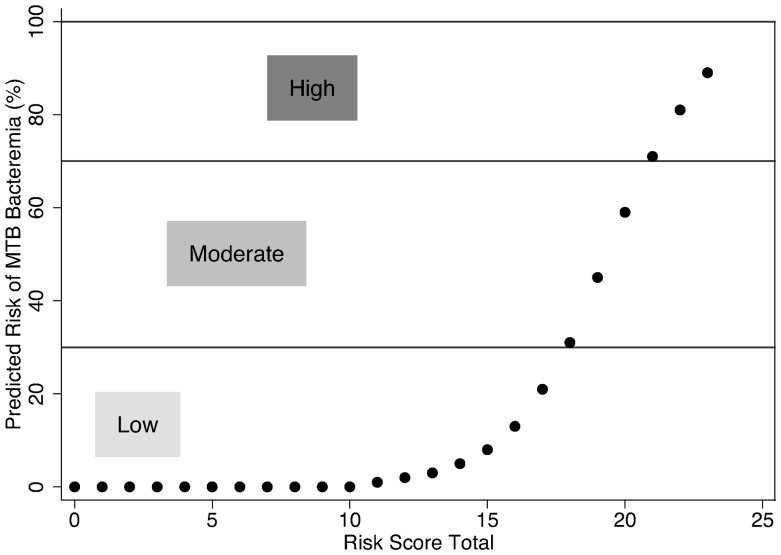
Risk of MTB bacteremia corresponding to MTB bacteremia risk score totals.